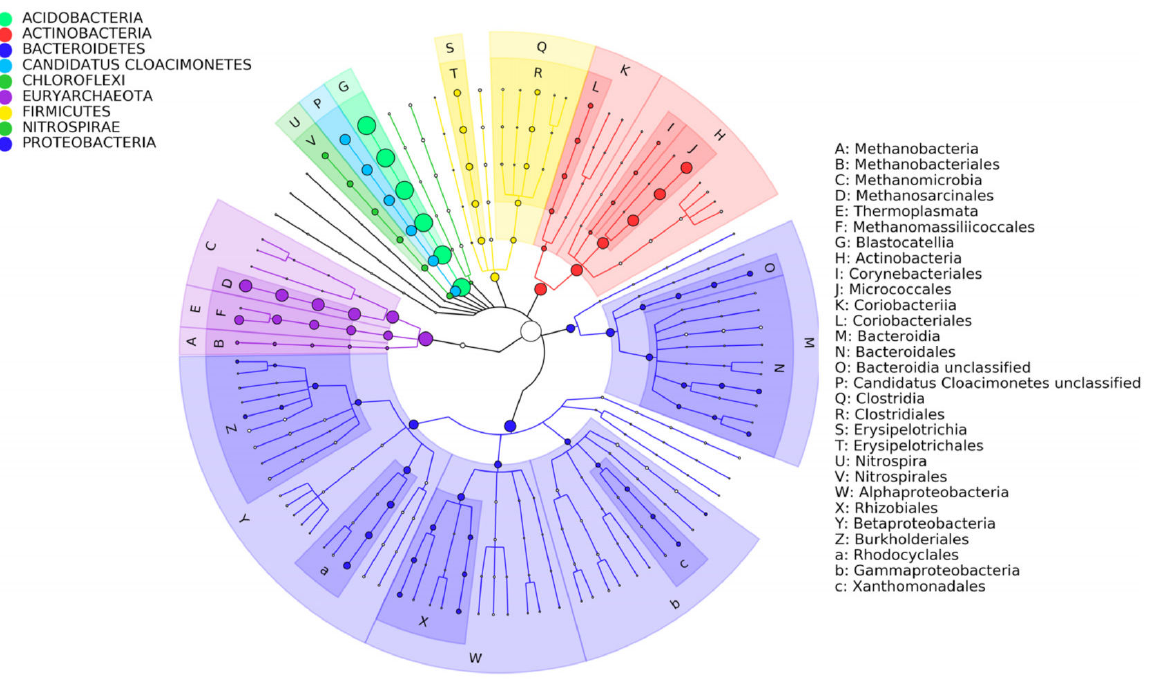
Figure 2. The structure of all microbial consortia in the sequenced samples of sewage sludge. Phylum nodes are colored, and branch areas are shaded. The first two outer tracks (with letters) indicate Classes and Orders. The next seven tracks (Species, Genera, Family, Order, Class, Phylum, Kingdom) describe relative bacterial community abundance calculated by Metaphlan software. The size of the node is relative to the abundance of each taxonomic